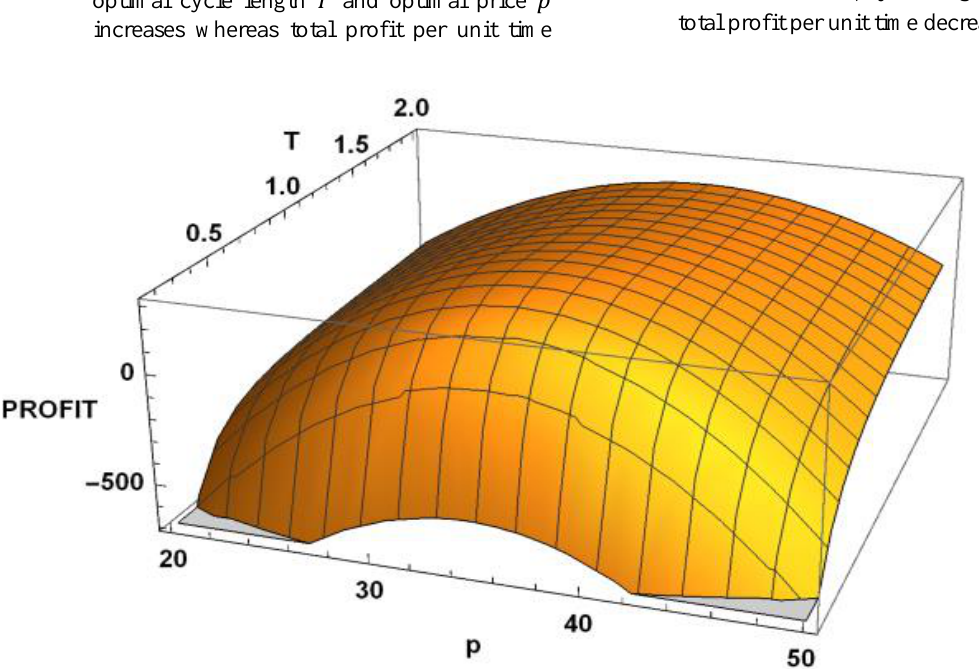
Figure 2. A three-dimensional plot showing the total profit function for the above numerical example Table 2. Sensitivity analysis with respect to input parameters